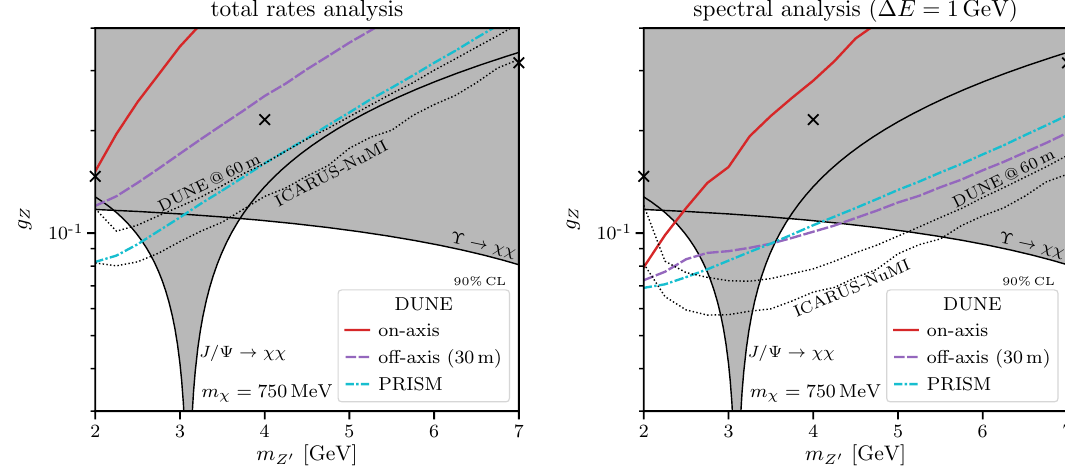
Figure 6 . Projected upper exclusion limits for the leptophobic DM model, assuming the DM particle φ carries a U(1) charge of z = 3 . Colored exclusion curves correspond to different DUNE- B φ PRISM running strategies namely on-axis-only running (red solid), off-axis-only running (purple dashed), and equal running times at seven different locations (cyan dot-dashed). Black dotted exclusion curves show the constraints that could be obtained at ICARUS-NuMI using neutrinos from the NuMI beam and at a hypothetical detector placed 60 m off-axis in the DUNE/LBNF beam. Like for the dark photon model (cf. figure 3), we compare a total rates analysis (left panel) to an analysis harnessing the full energy spectrum of events (right panel). We also compare to existing limits from invisible J/ψ and Υ decays at BaBar [65, 66] (gray shaded regions). The black crosses indicate the exemplary model parameter points presented in figure